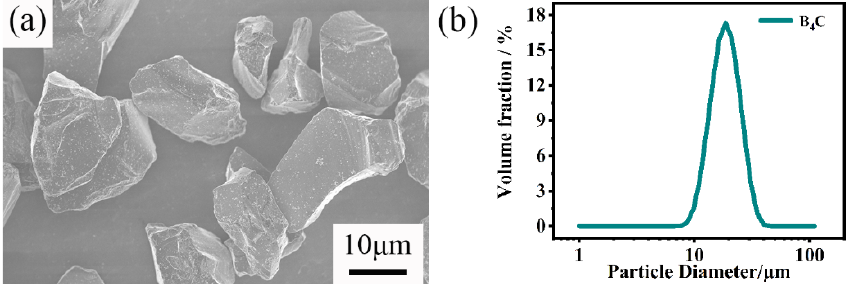
Figure 1. ( a ) SEM image and ( b ) particle size distribution of raw B 4 C powders. Table 1. The nomenclature of composites and their raw material composition.